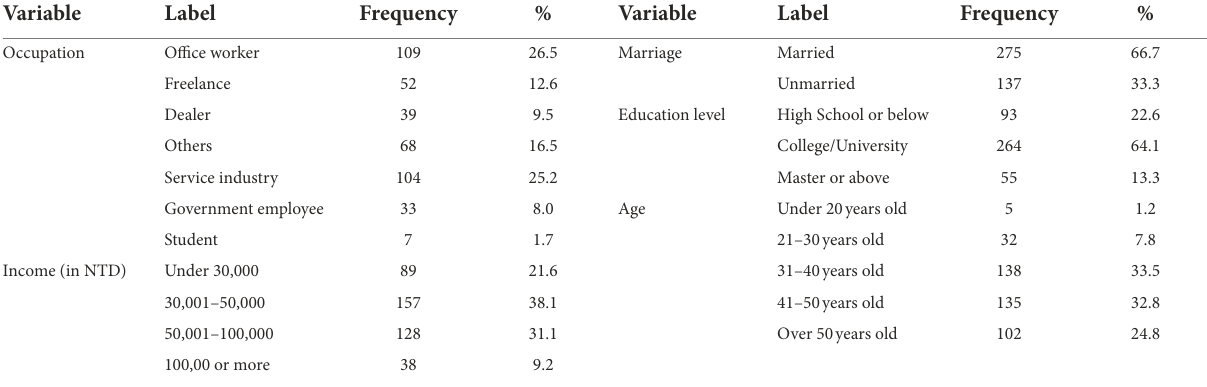
TABLE 1 Distribution of demographic